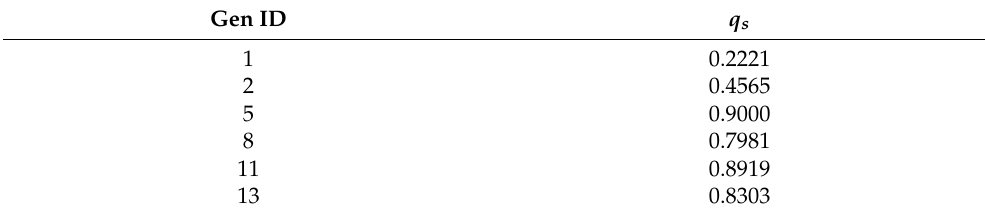
Table 2. Assumed values of q s